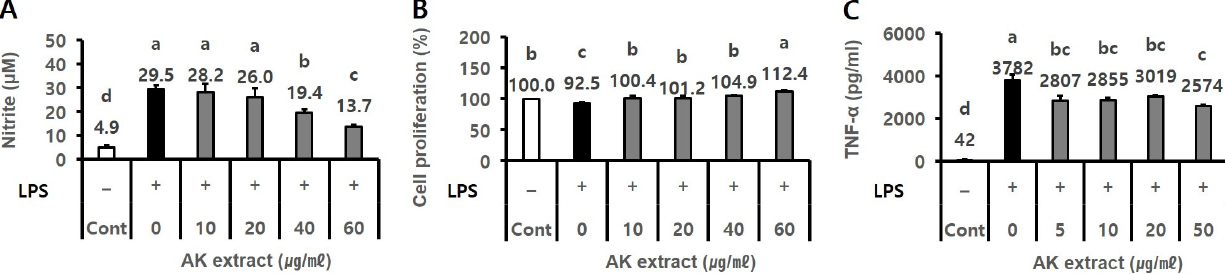
Figure 1. Effect of AK extract on ( A ) NO production, ( B ) cell proliferation in LPS-treated BV2 microglial cells, and ( C ) TNF- α level in LPS-treated RAW264.7 cells. Cells (2 × 10 5 cells/mL for BV2, 3 × 10 5 cells/mL for RAW264.7) seeded in a 48-well plate were treated with sample extracts for 2 h, and serum-free medium was used as the control. The wells were treated with 0.5 µg/mL LPS for 21–24 h. The optical density for the analysis of nitrite ( n = 3), cell proliferation ( n = 3), and TNF- α ( n = 2) was measured at 520 nm, 540 nm, and 450 nm, respectively. ( – ), LPS-untreated experiment; (+), LPS-treated experiment; LPS, lipopolysaccharide; Cont, control; Statistical analysis was performed using SAS software. The values indicated with different letters were found to differ significantly at p < 0.05 by Duncan’s multiple range test.